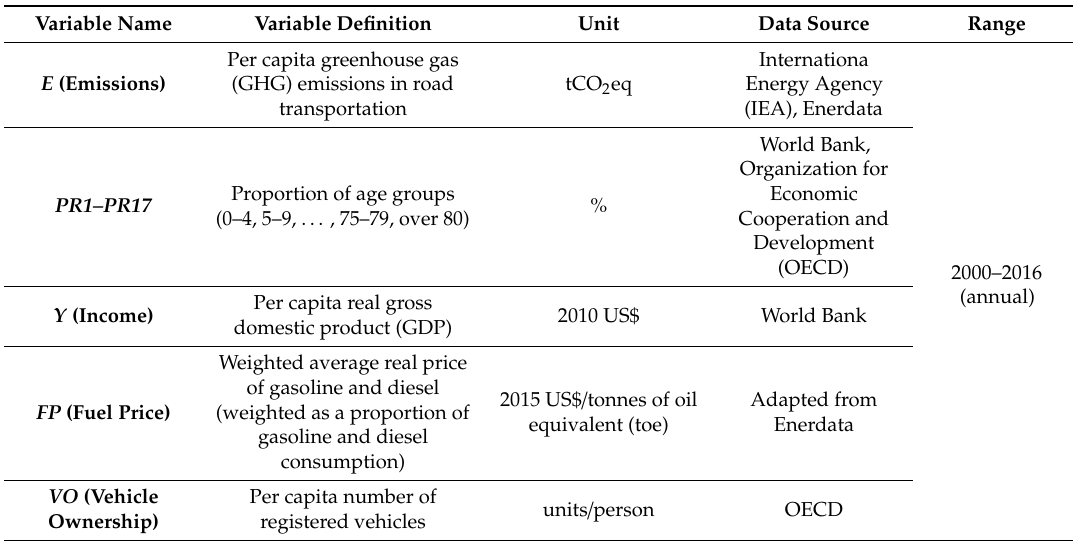
Table 1. Variable